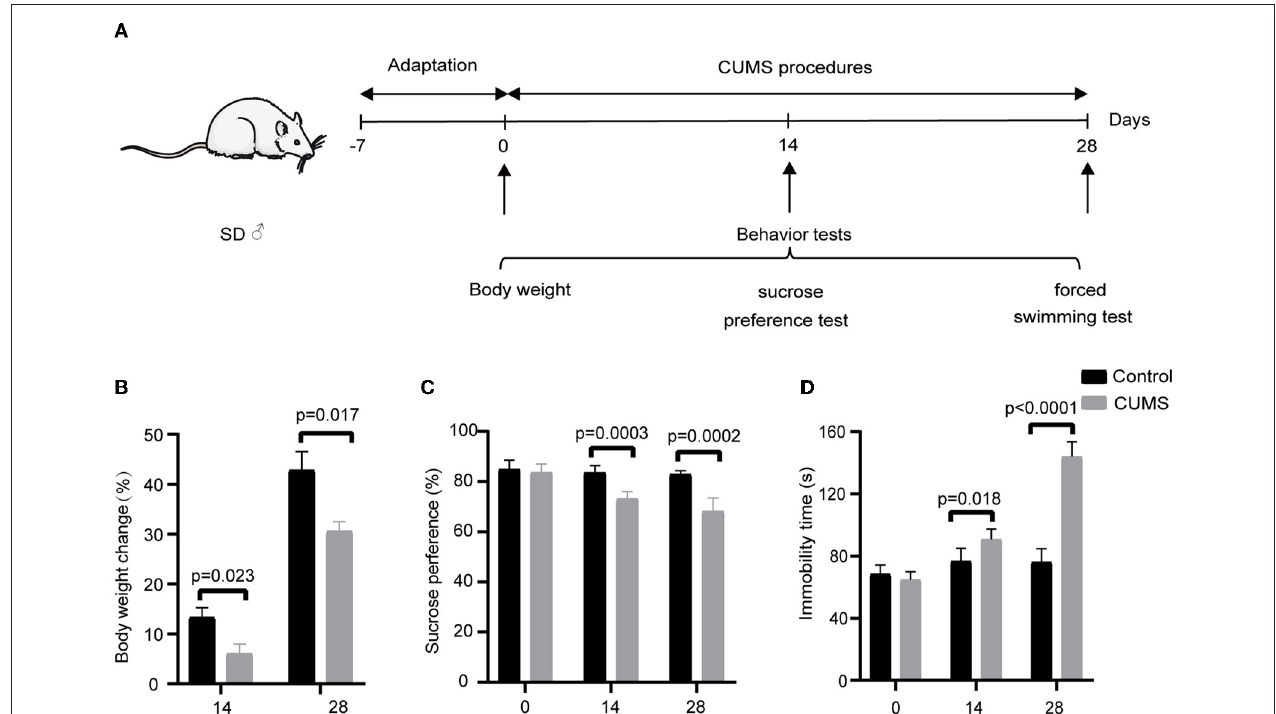
FIGURE 1 | (A) Schedule of CUMS exposure; depression-like behavior was examined at days 0, 14, 28 (Mean ± SD, n = 5) by (B) body weight change measurement, (C) sucrose preference test, and (D) forced swimming test. CUMS group vs. control group.